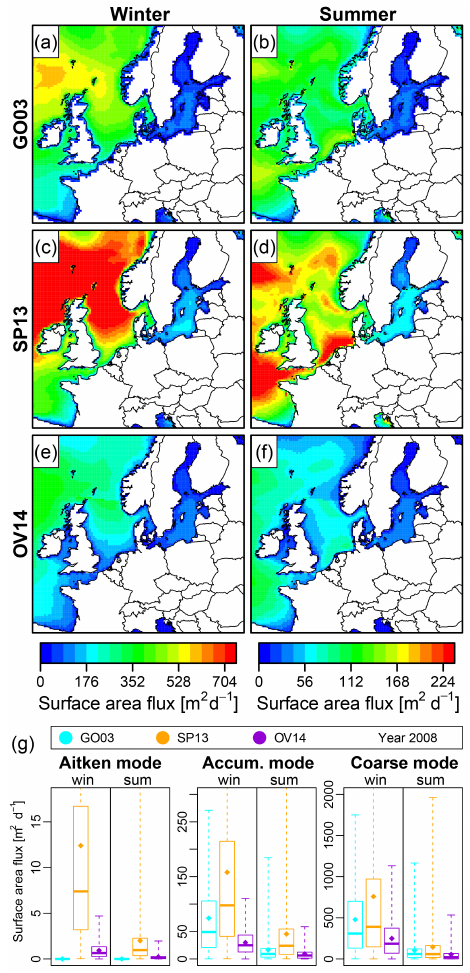
Figure 8. Similar to Fig. 7 but showing sea salt surface area emis- sions. (a – f) The 2-month average surface area emissions (g) box plots of surface area